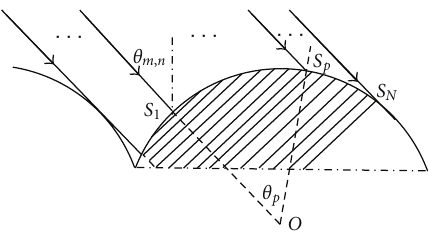
Figure 4: Schematic showing parallel light rays incident on the rear acidic-textured